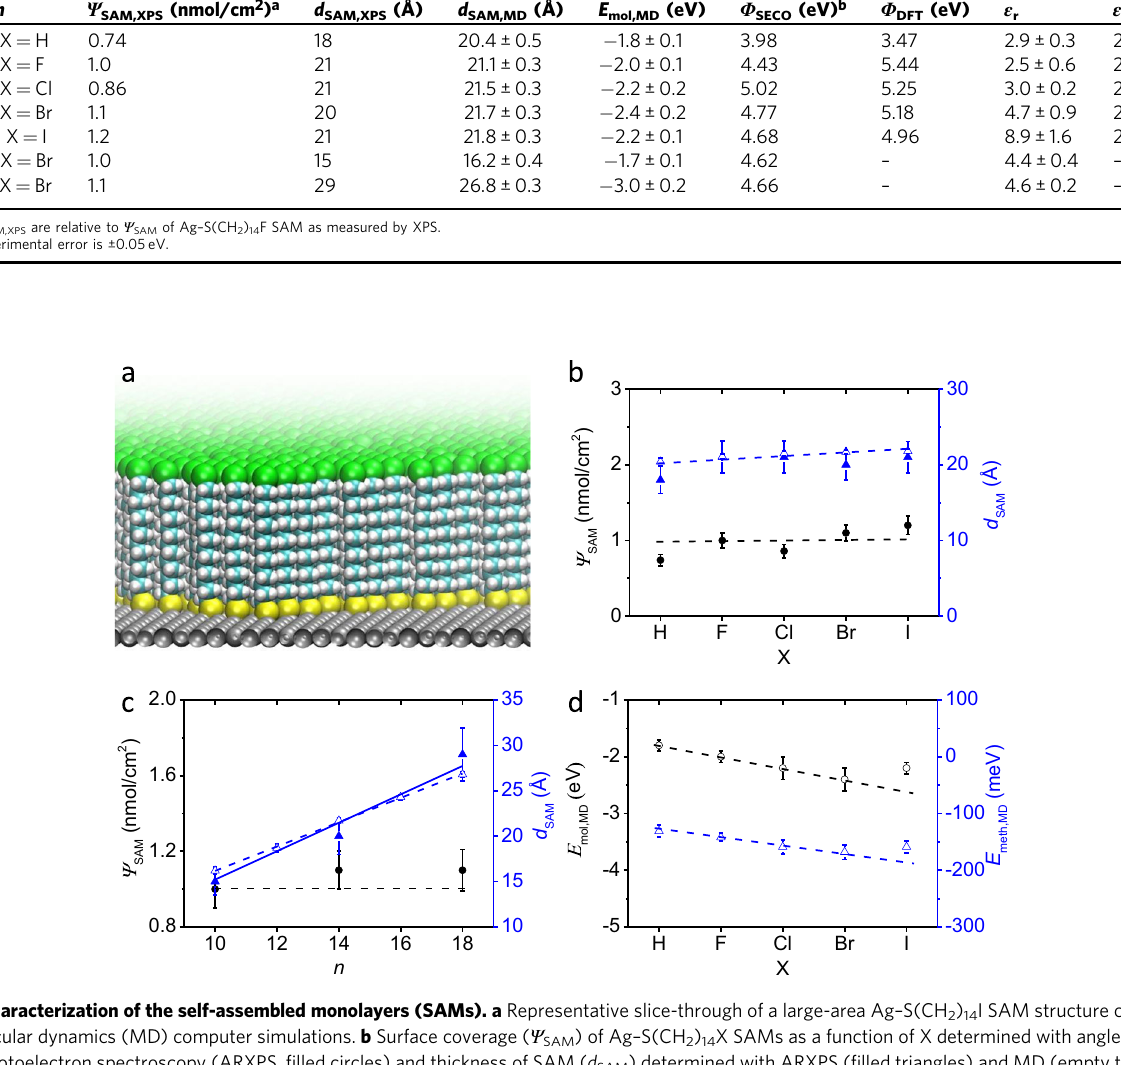
fi tting errors